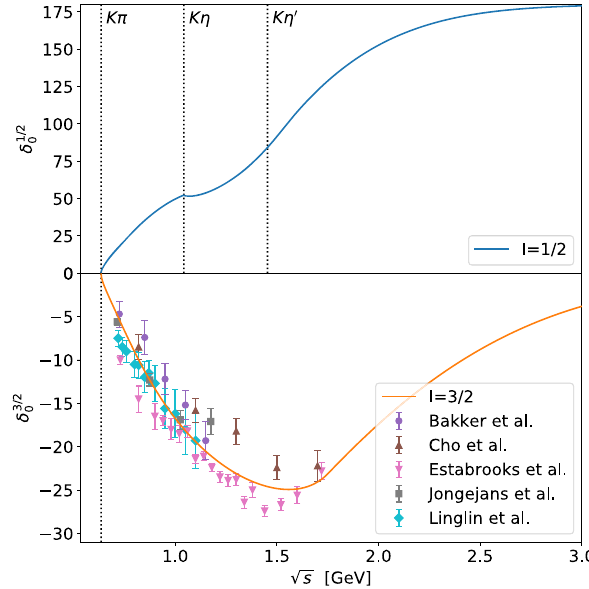
Fig. 1 Isospin-1 / 2 and -3 / 2 phase shifts including their high-energy extension. The latter is compared to the data from Bakker et al. [58], Cho et al. [59], Estabrooks et al. [60], Jongejans et al. [61], and Linglin et al.